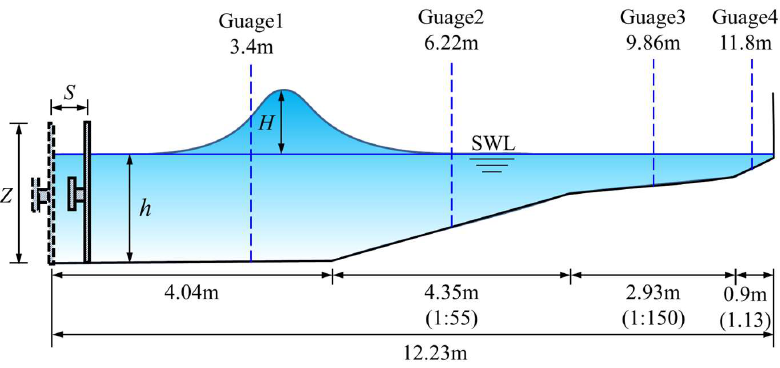
Figure 14. Set-up for solitary wave run-up on the bottom with varying slope angle.